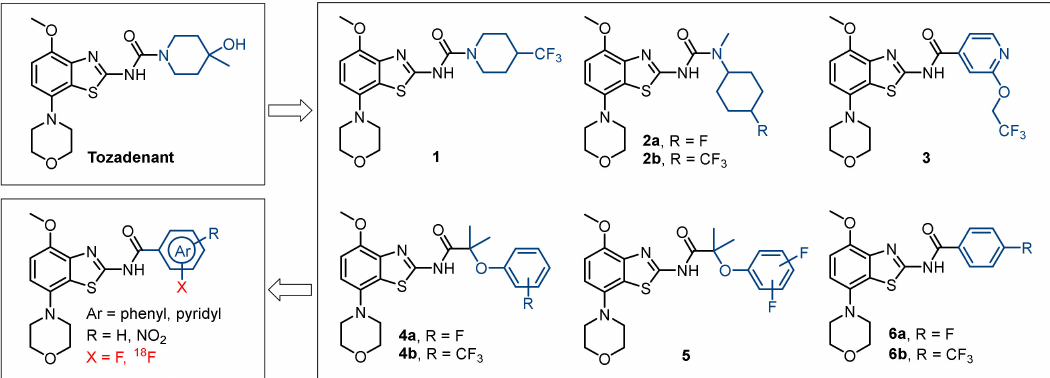
Figure 2. Design of a novel 18 F-labeled radiotracer based on the lead compound tozadenant and its fluorinated